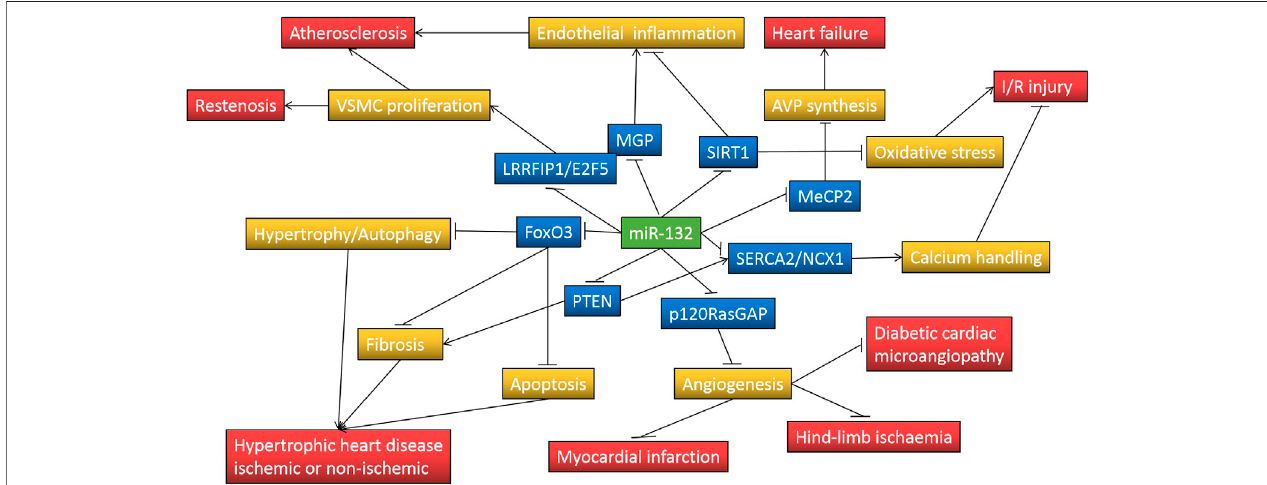
FIGURE 1 | MiR-132 regulates pathological processes involved in cardiovascular disease through repressing target genes expression. Symbol “ ↑ ” indicates increase and “ ⊥ ” indicates decrease; FoxO3, forkhead box protein O3; PTEN, phosphatase and tensin homolog; p120RasGAP, p120 Ras GTPase-activating protein; SERCA2,sarcoplasmicreticulumCa(2+)-ATPase;NCX1,Na(+)-Ca(2+)exchanger1;MeCP2,methyl-CpG-bindingprotein2;SIRT1,silentinformationregulator1;MGP, matrix Gla protein; LRRFIP1, leucine-rich repeat (in Flightless 1) interactingprotein-1; E2F5, E2F transcription factor 5; AVP, arginine vasopressin; VSMC, Vascular smooth muscle cell; I/R,